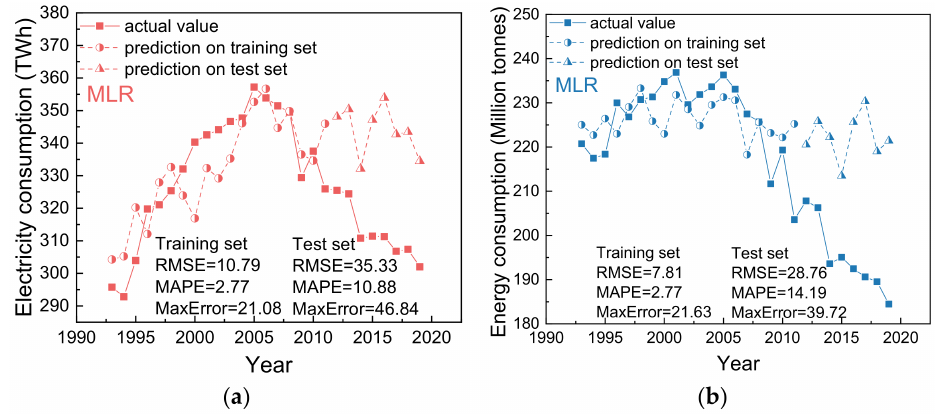
Figure 6. Results of MLR model. (( a ) electricity consumption; ( b ) energy consumption).